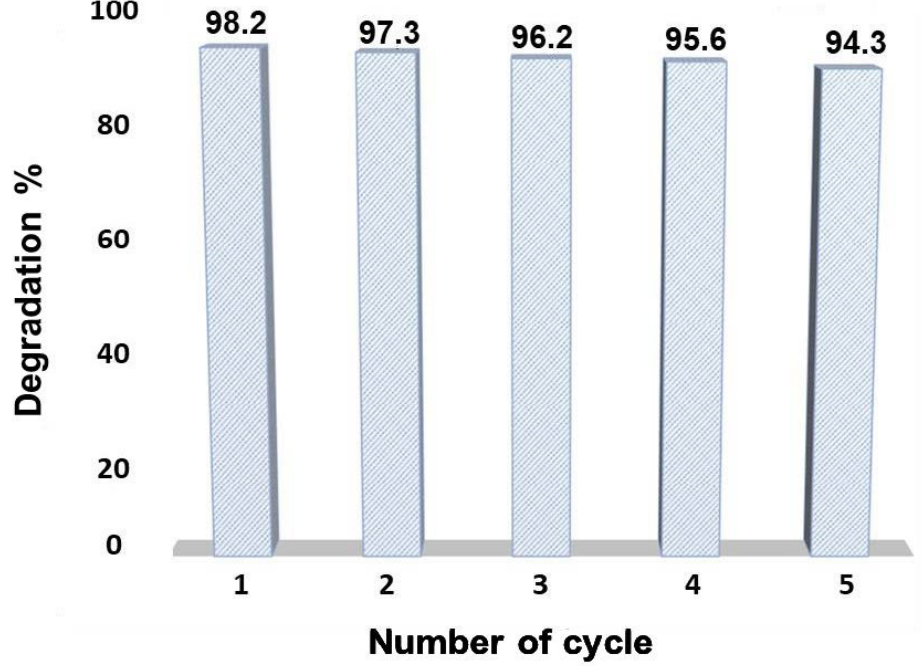
Figure 13. Reusability of the prepared TiO 2 NPs for the degradation of Remazol Brilliant Red F3B (Reactive Red 180).